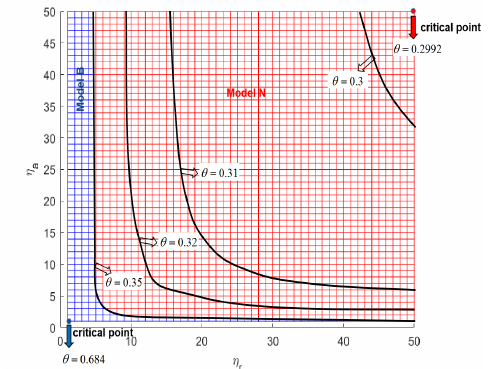
Figure 7. The boundaries and critical points on η r − η a plane.